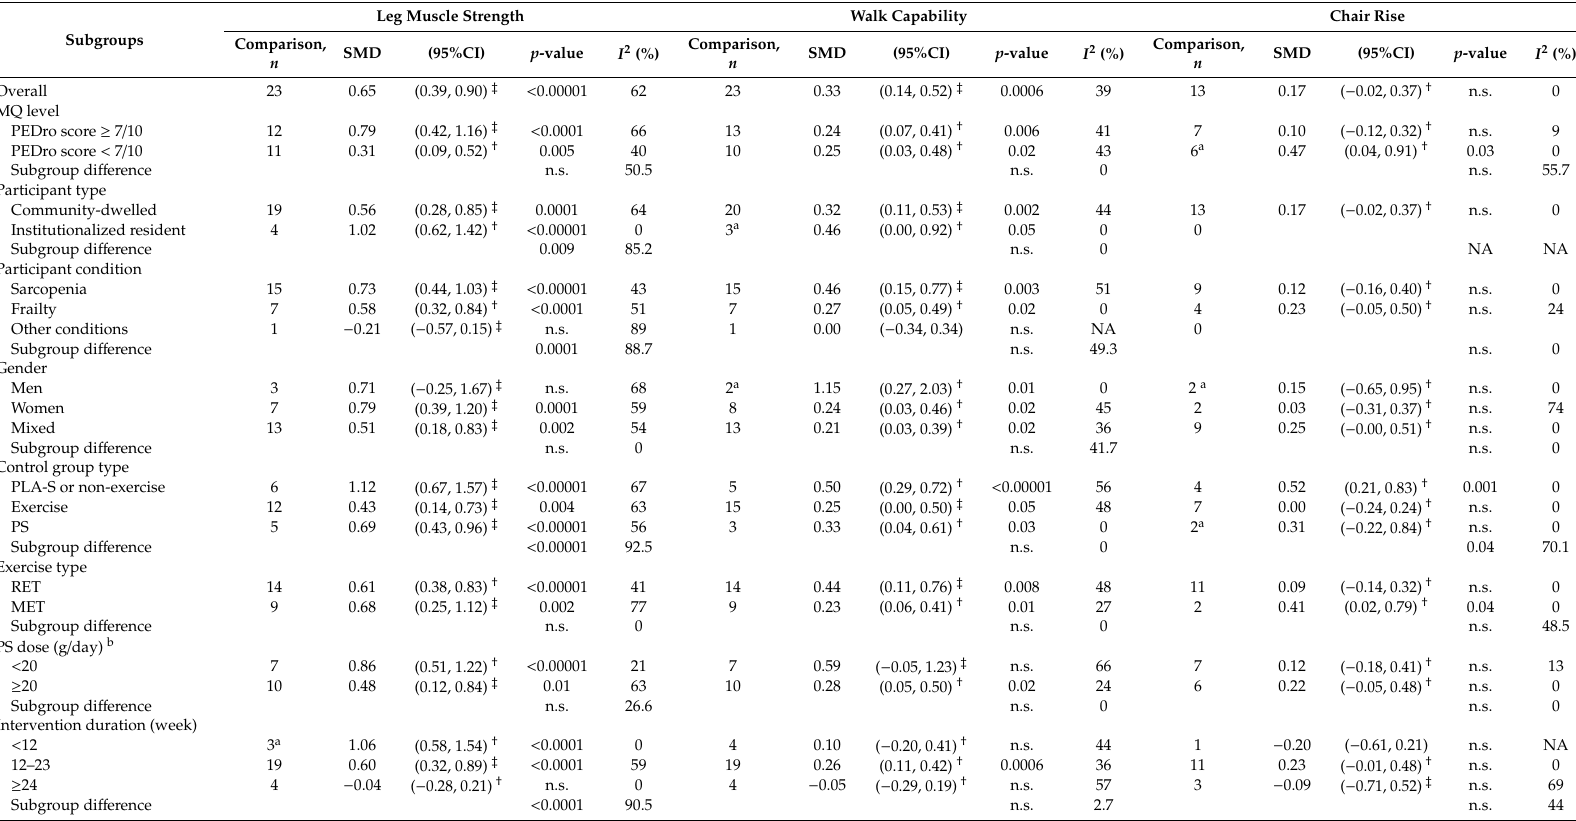
Table 4. Summary of overall e ff ects and subgroup analyses results for physical